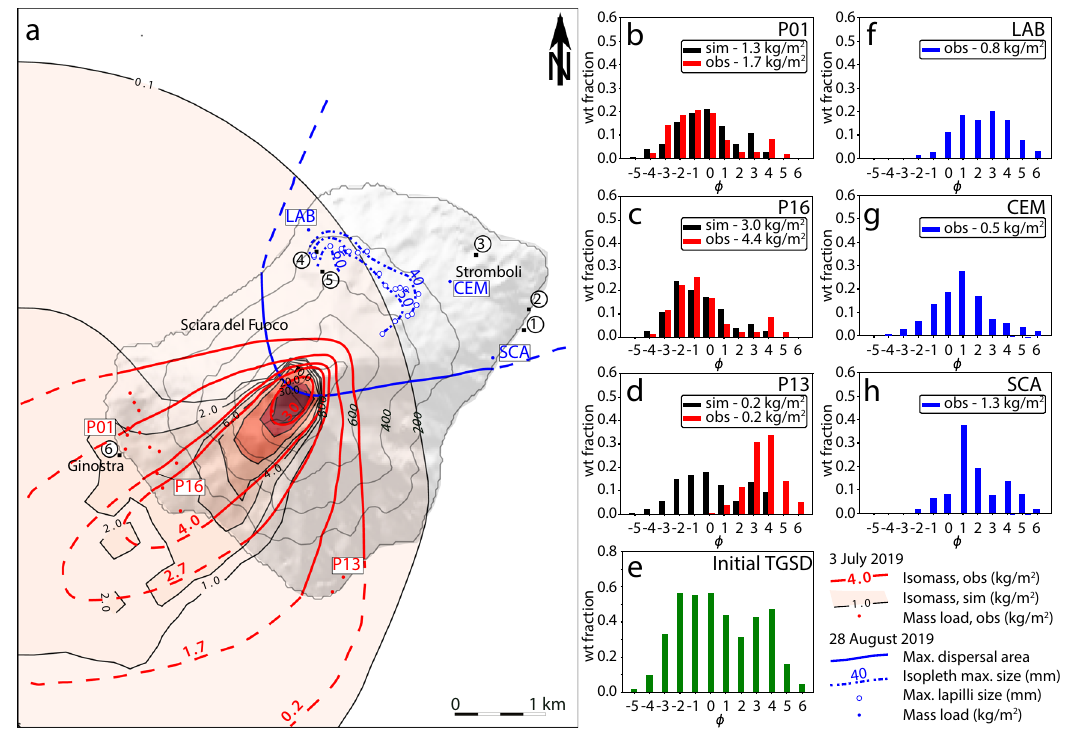
Fig. 4 Dispersal of tephra fallouts from both paroxysms. a The mass load of the fallout deposit of 3 July measured at 16 locations (red points), and observed (red lines) and simulated (black lines contouring pink-shaded areas, modeled by PLUME-MoM-TSM/HYSPLIT) isomasses. The deposit is simulated at 18:00 UTC (more than three hours after the explosion) and reveals a maximum ground load of about 30 kg m − 2 . Circled numbers indicate 6 high-risk sites considered in the discussion. Estimated dispersal area (blue lines), and isopleths of the maximum lapilli size (dotted blue lines, see “ Methods ” section) of the 28 August fallout deposit. Isopleths were interpolated based on data collected from 17 locations (blue circles; Supplementary Table 3). b – e Comparison of simulated (sim) and observed (obs) grain-size distributions at three sampling points (P01, P13, and P16), and Initial Total Grain-Size Distribution (TGSD) at the volcanic vent resulting from the inversion of the data for the 3 July paroxysm. f – h Observed grain-size distribution of three samples of the 28 August tephra fallout (LAB, CEM, SCA); on the basis of observations of the eruption by a witness, the sample collected at Labronzo is affected by the contribution of fi ne ash due to the elutriated cloud produced by the